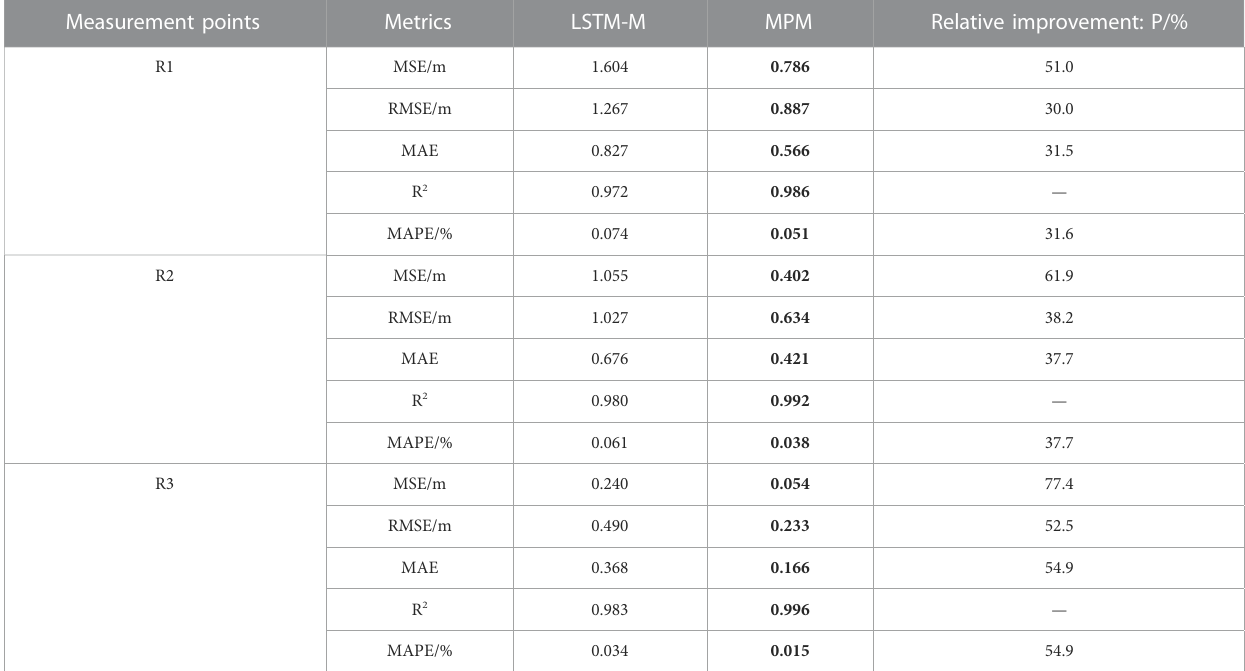
TABLE 5 Evaluation results of prediction models. Measurement